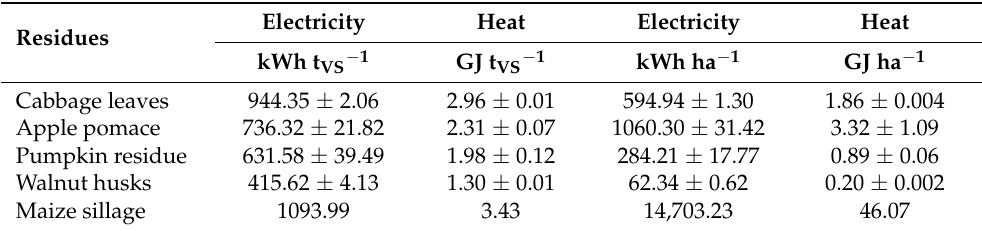
Table 3. Energy generation in anaerobic digestion of studied residues calculated based on the BMP